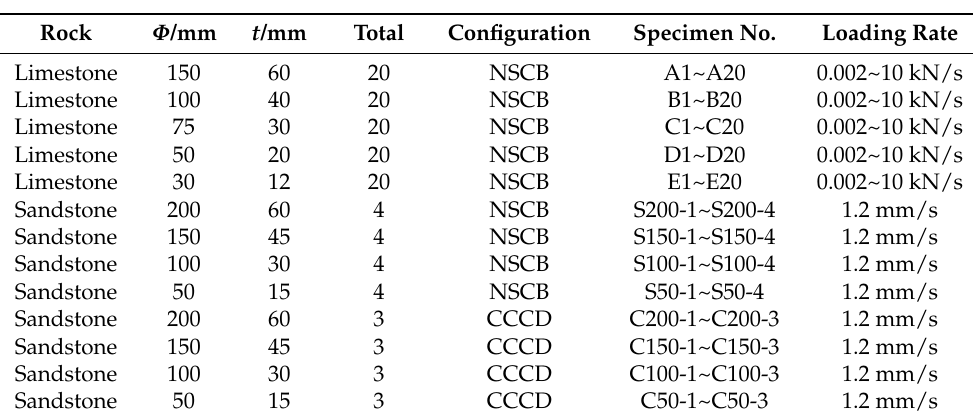
Table 2. Sizes, number, loading rate and configuration of all